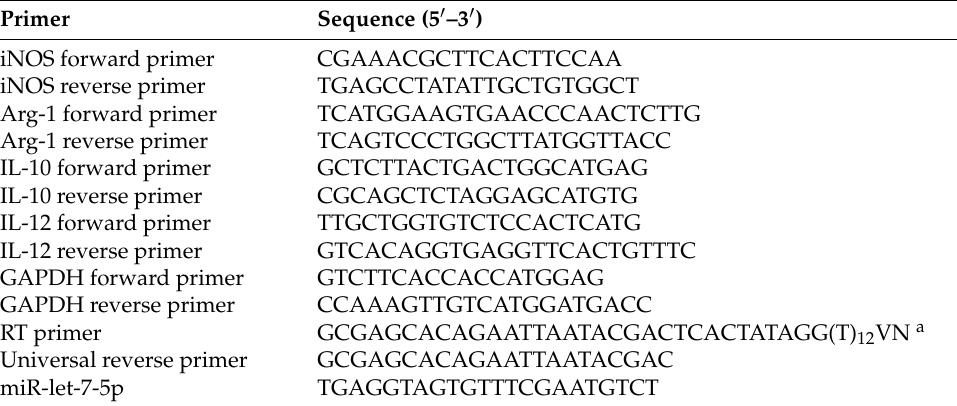
Table 1. The primers used in this